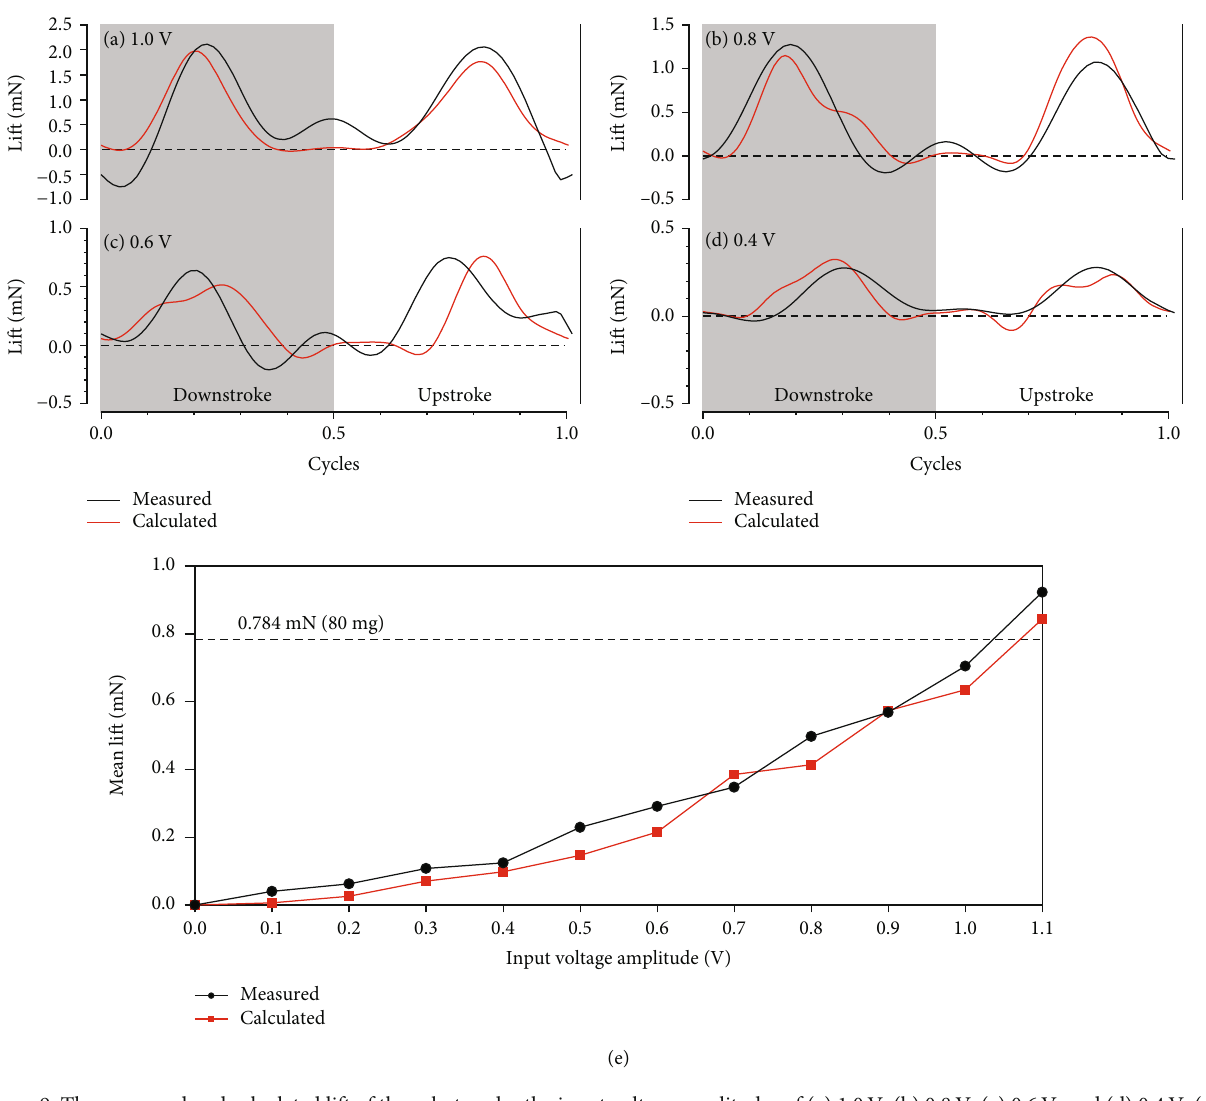
Figure 9: The measured and calculated lift of the robot under the input voltage amplitudes of (a) 1.0V, (b) 0.8 V, (c) 0.6V, and (d) 0.4 V. (e) The relationship between the mean lift of the robot and the input voltage